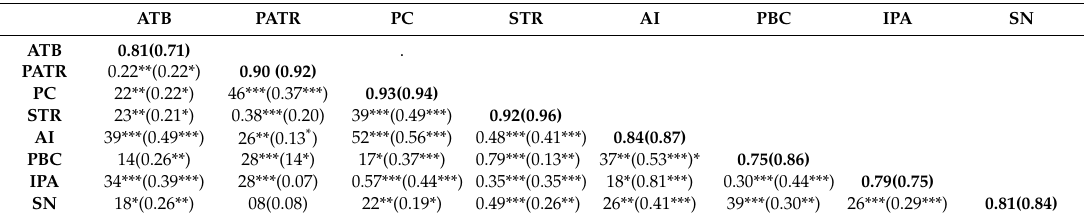
Table 2. Means comparisons variables related to physical activity intentions after finishing secondary school female vs. male